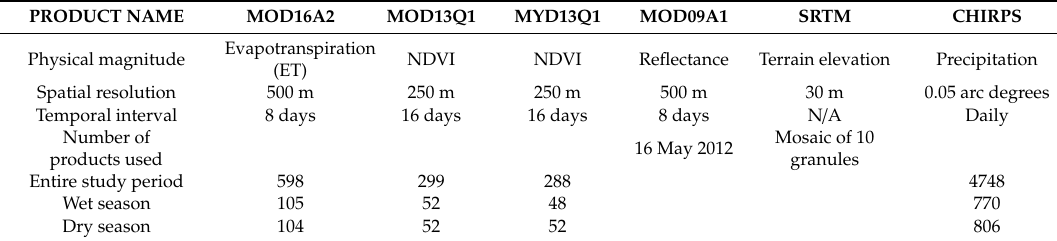
Table 1. Datasets used in this